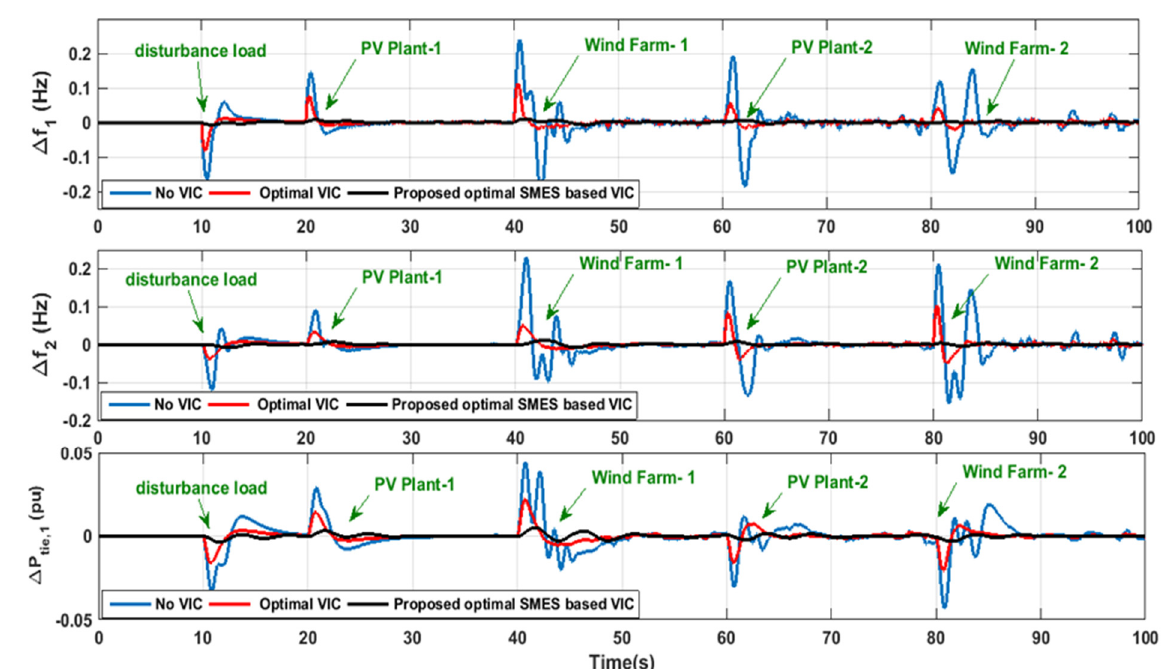
Figure 18. The system under consideration performance for case B, scenario 3.